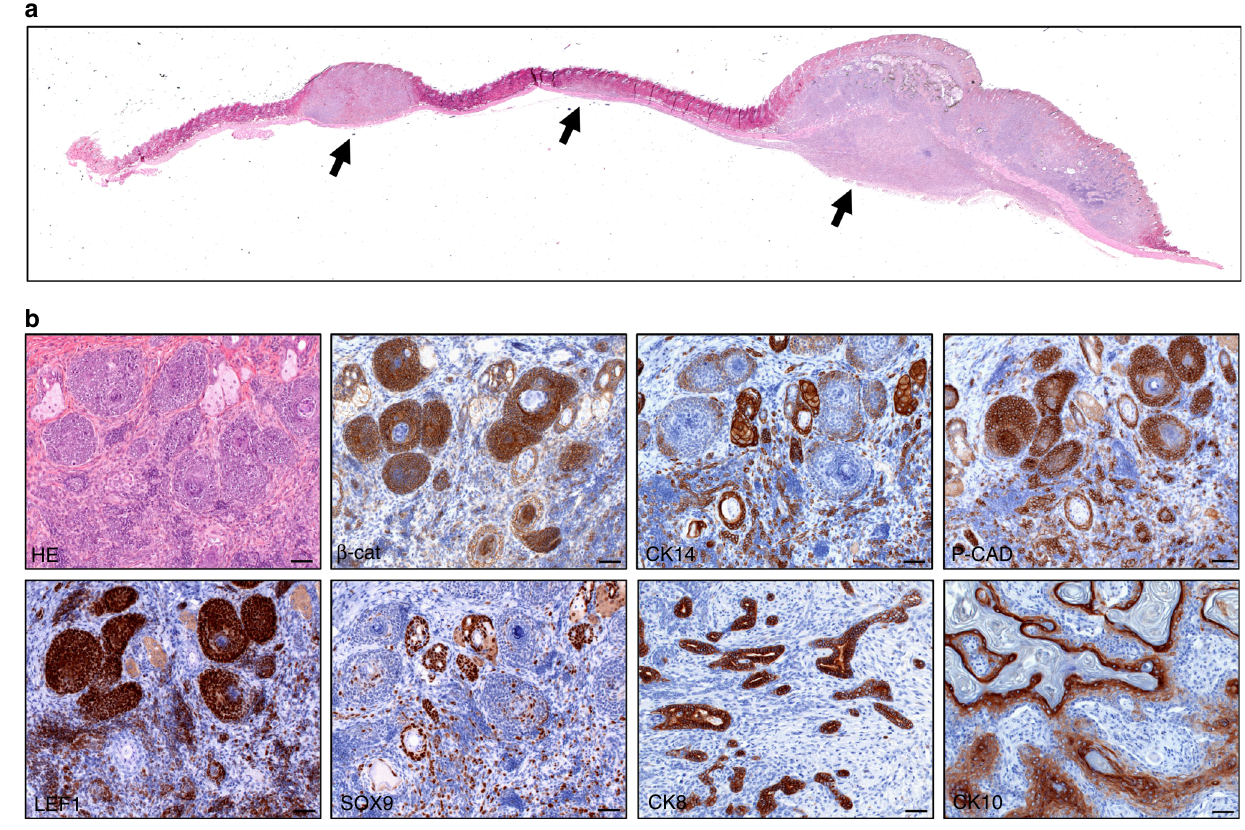
Fig. 1 Cdkn2ab − / − mice show multiple skin trichoblastic carcinomas. a Total scan image of the skin region representing multiple skin tumours (arrows, scale bar 100 mm). b H&E and IHC characterization of skin tumours consisting largely of hair germ (LEF1 + , P-CAD + , SOX9 + ), basal/squamous (CK14 + /CK10 + ) cells and dermal papillary cells (LEF1 + ), also showing strong regional β -Catenin positivity (scale bars: 20 μ